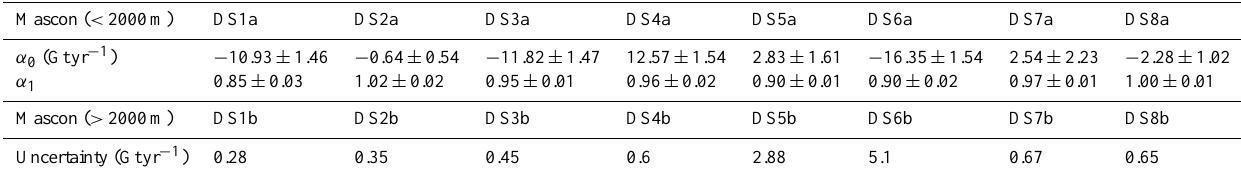
Table A1. The linear-fit parameters α 0 and α 1 that describe the relationship between the regional simulated mass balance and the approxi- mations obtained after the inversion procedure, as applied to GRACE data of the coastal regions. For the interior GrIS regions, we show the approximation errors as additional uncertainties.